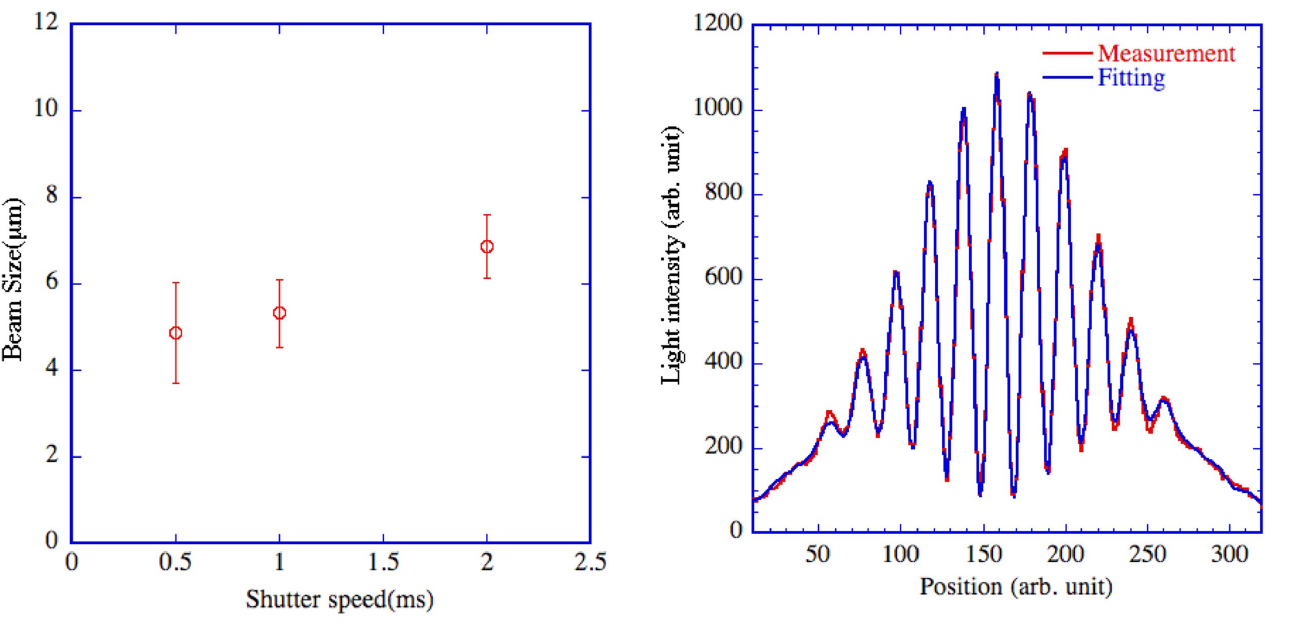
FIG. 7. (Color) Measured beam size as a function of the expo- sure